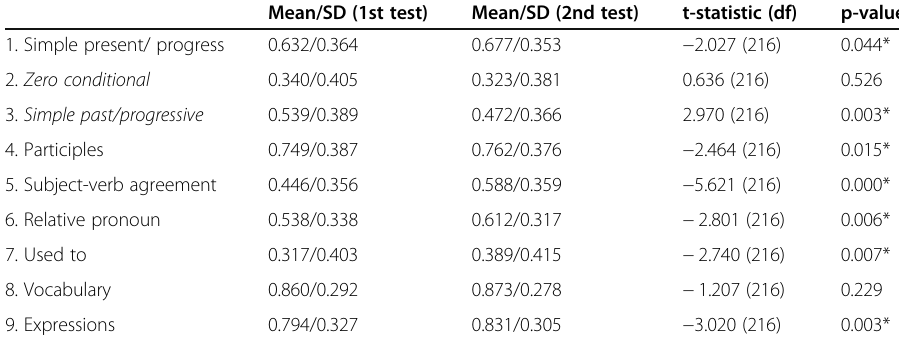
Table 9 Comparisons of mean mastery probabilities in the first and second